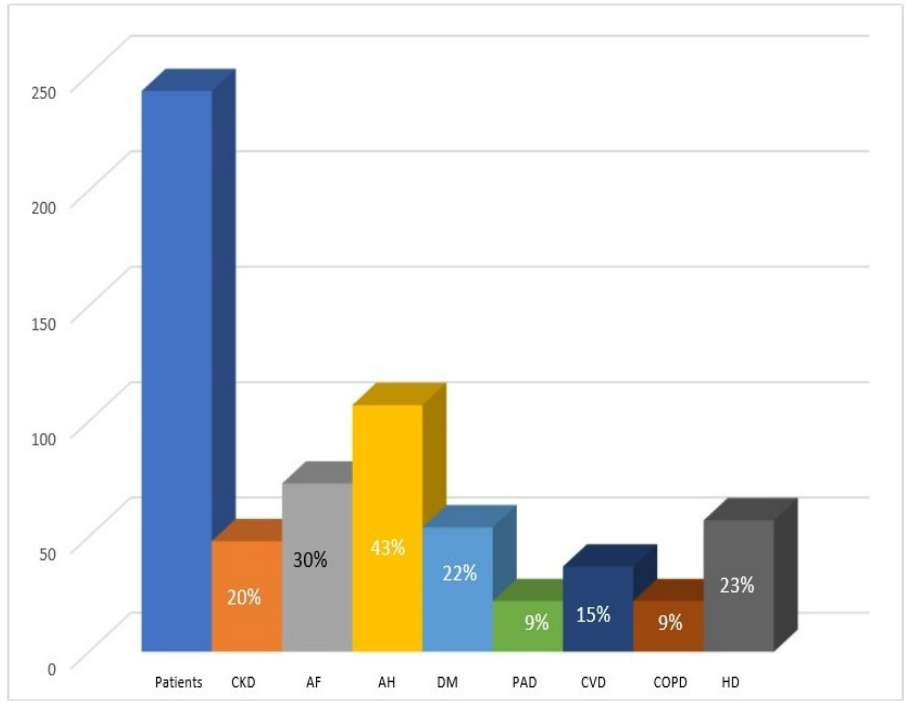
Figure 1. Distribution of co-morbidities by primary diagnosis. CKD: chronic kidney disease; AF: atrial fibrillation; AH: arterial hypertension; DM: diabetes mellitus; PAD: peripheral artery disease; CVD: cerebrovascular disease; COPD: chronic obstructive pulmonary disease; HD: heart disease.